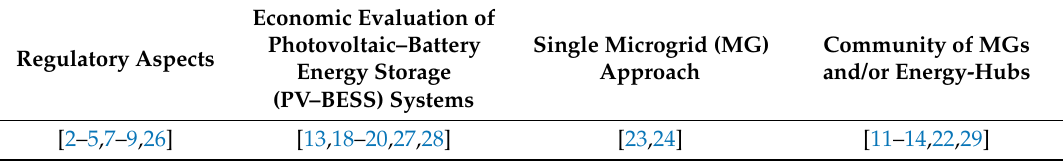
Table 1. Summary of the literature